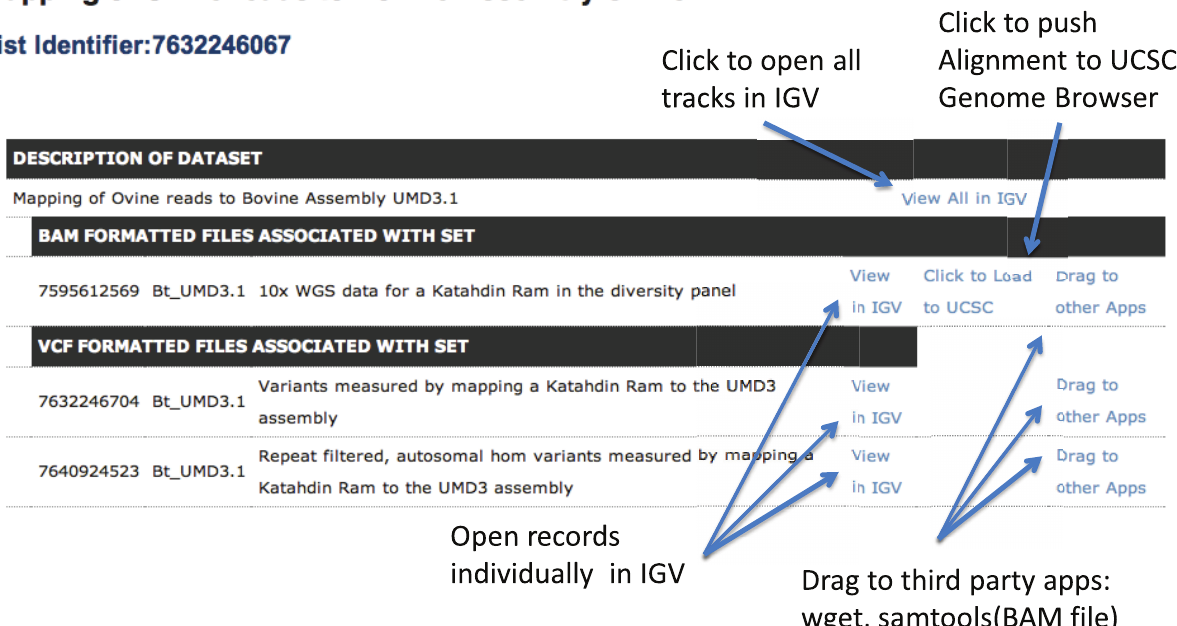
Figure 1. Screen shot of web page with links for the mapped Katahdin Ram reads to the bovine reference genome UMD3.1 (See the Methods for detail description of use).